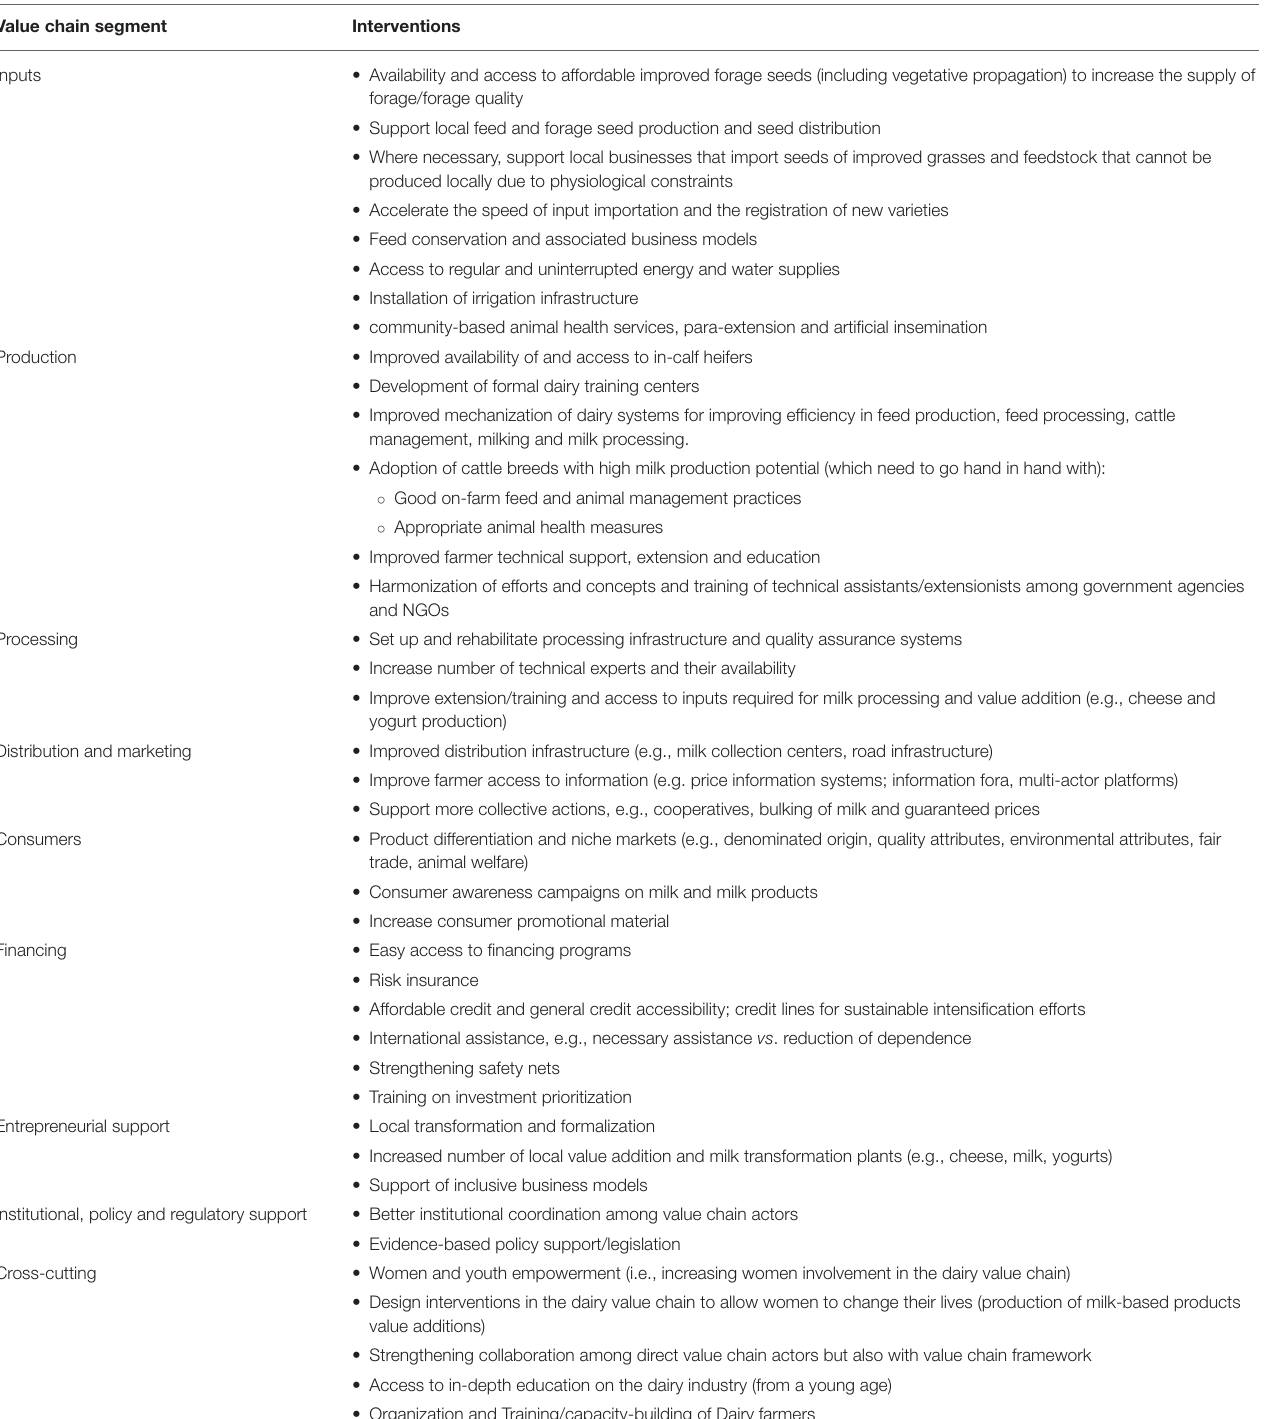
TABLE 2 | Key interventions for improving the dairy value chain in